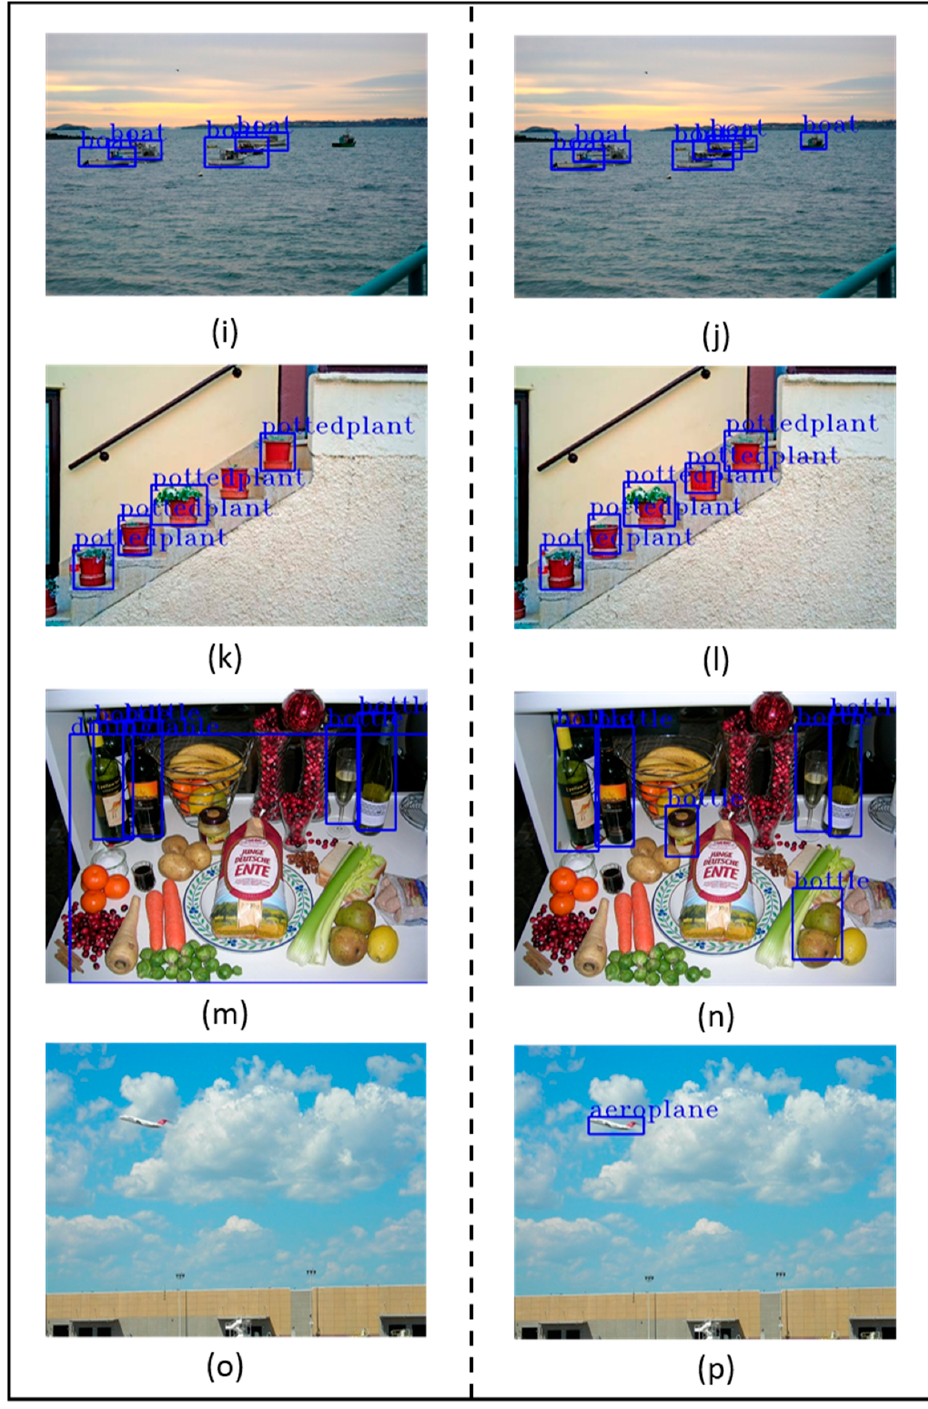
Figure 5. Examples of predicted bounding boxes generated by the baseline model and our proposed model tested on the PASCAL visual object classes (VOC) dataset. Left column images ( a , c , e , g , i , k , m , o ) show the results of SSD (i.e., choosing the highest score proposal as the pseudo-ground truth). Right column images ( b , d , f , h , j , l , n , p ) show some bounding boxes produced by our method (i.e., applying EMBs). Applying EMB to SSD to detect objects yields better outcomes than the original SSD in almost all cases. However, as shown in ( n ), objects with similar colors and appearances are sometimes incorrectly predicted.